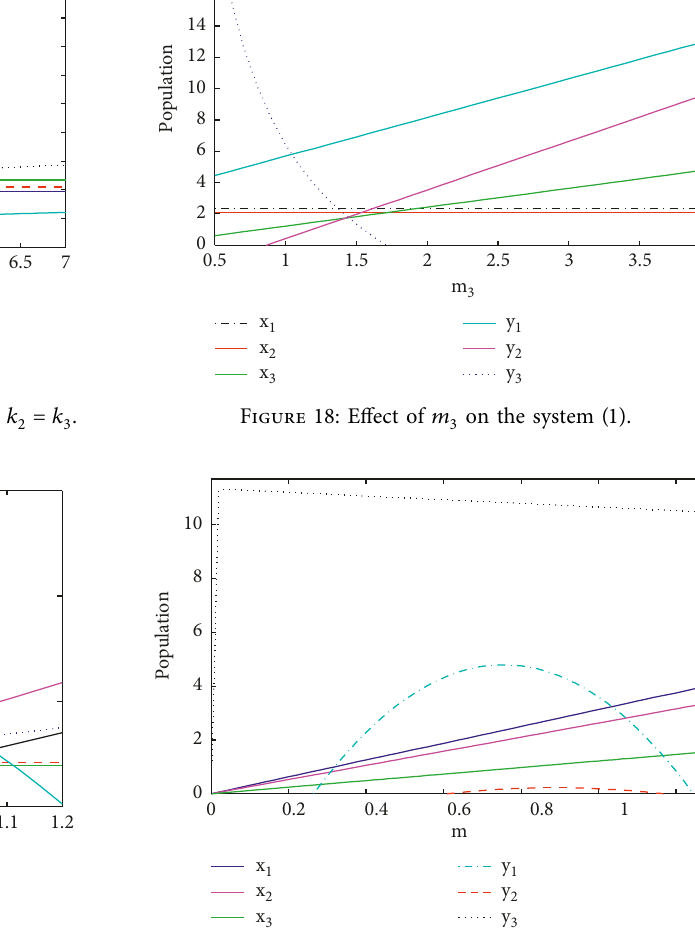
Figure 16: Effect of m